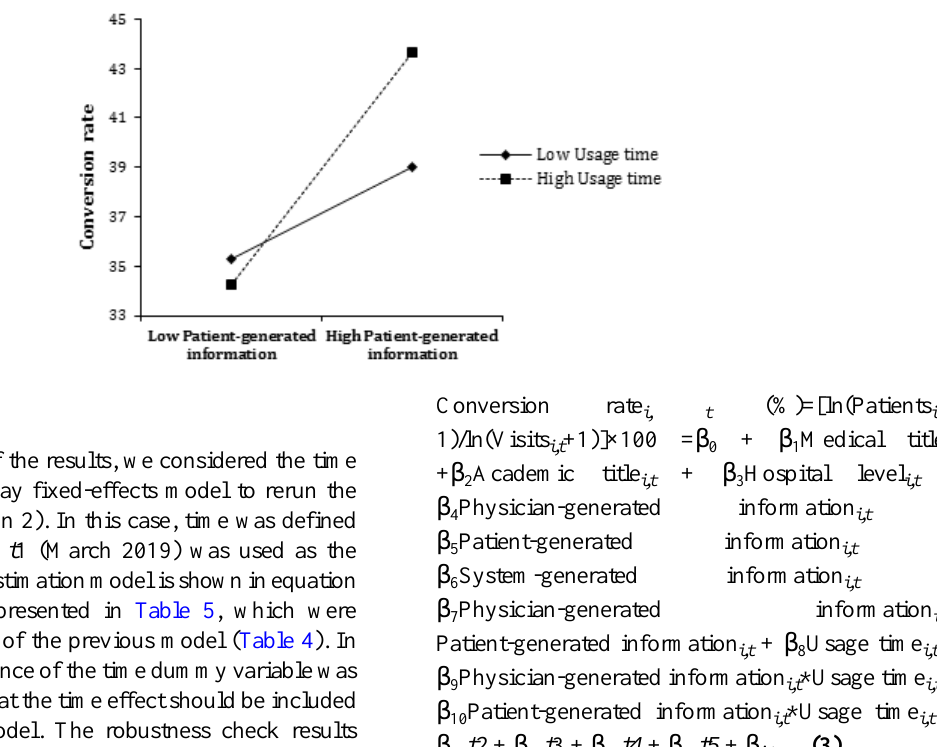
Figure 6. The moderating effect of usage time on patient-generated information and the conversion